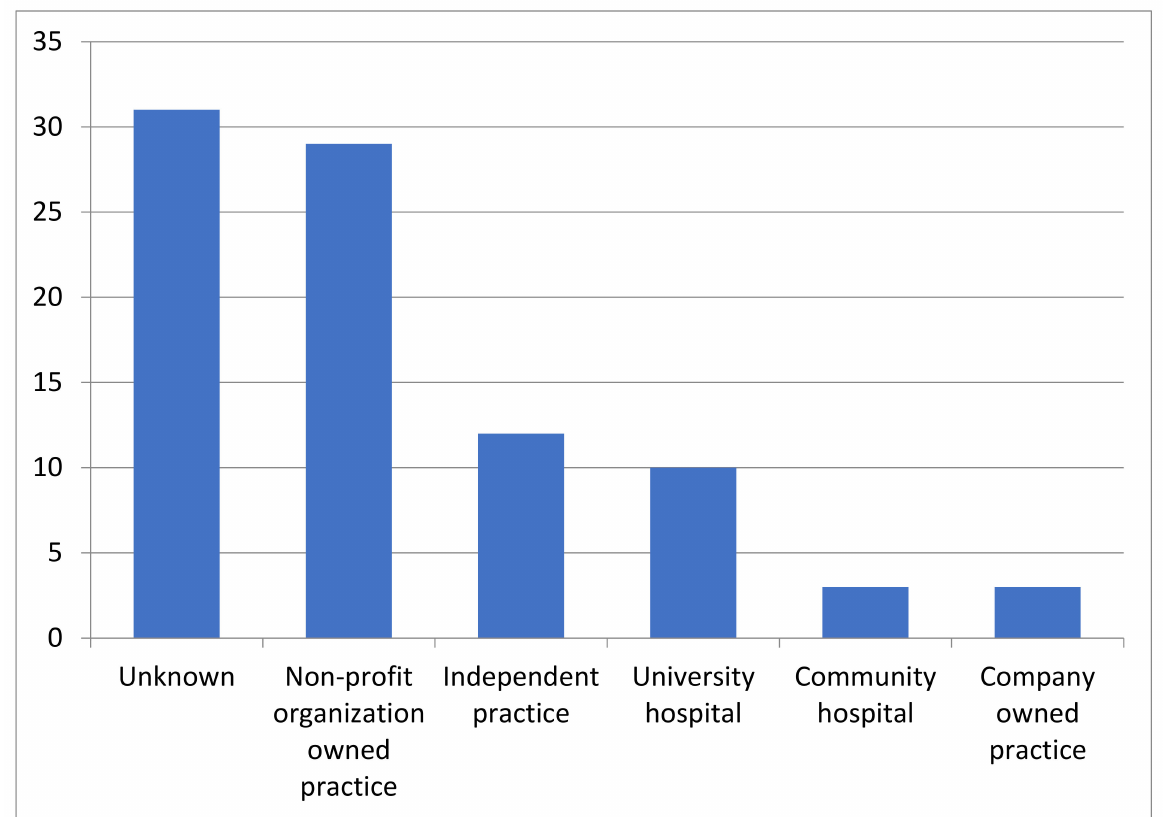
Figure 1. Affiliation of 119 survey participants.